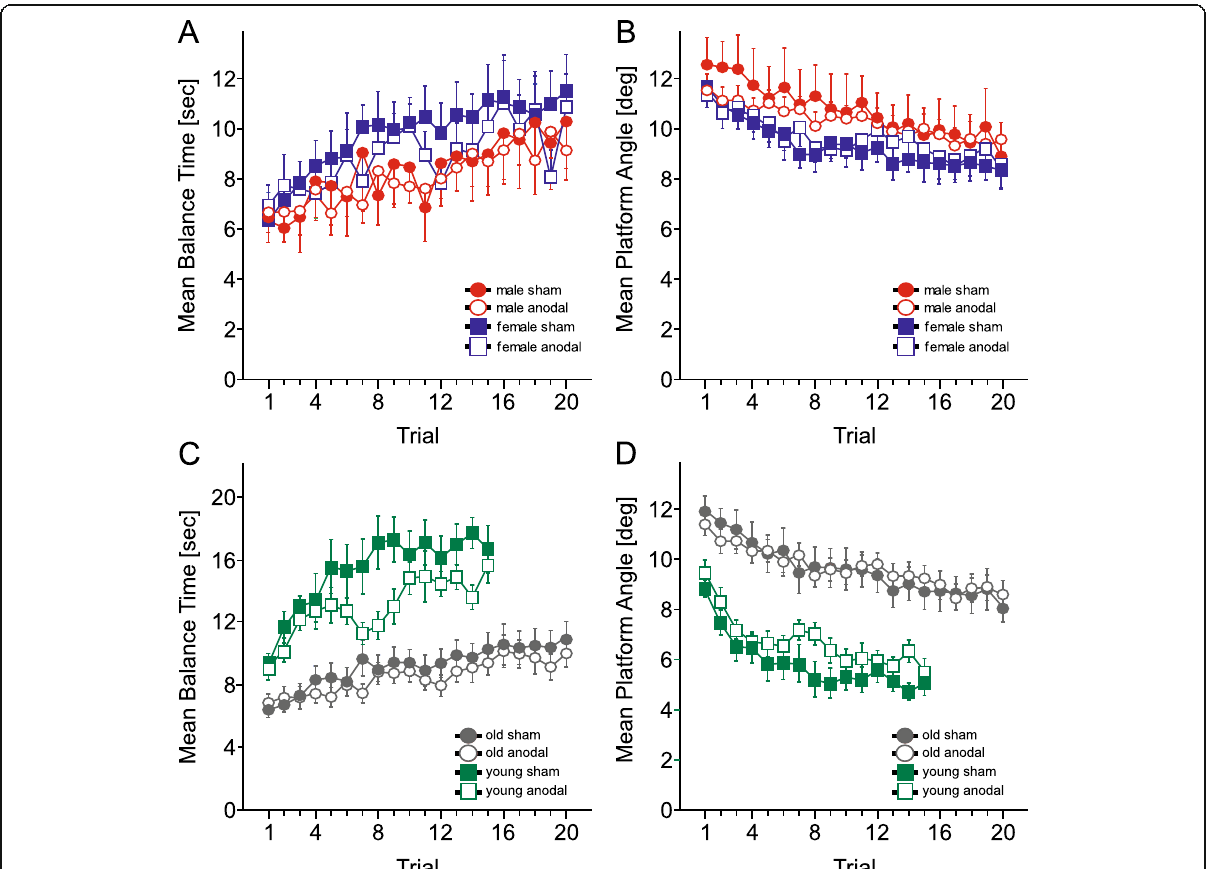
Fig. 5 Mean balance time and standard error of the mean ( a , c ) and mean platform angle and standard error of the mean ( b , d ) in each stimulation group, considering male and female participants separately ( a , b ) and comparing old and young participants in each stimulation group ( c , d ). Red circles: Male participants sham, white circles: male participants anodal, blue squares: female participants sham, white squares: female participants anodal. Grey circles: old participants sham, white circles: old participants anodal, green squares: young participants sham, white squares: young participants